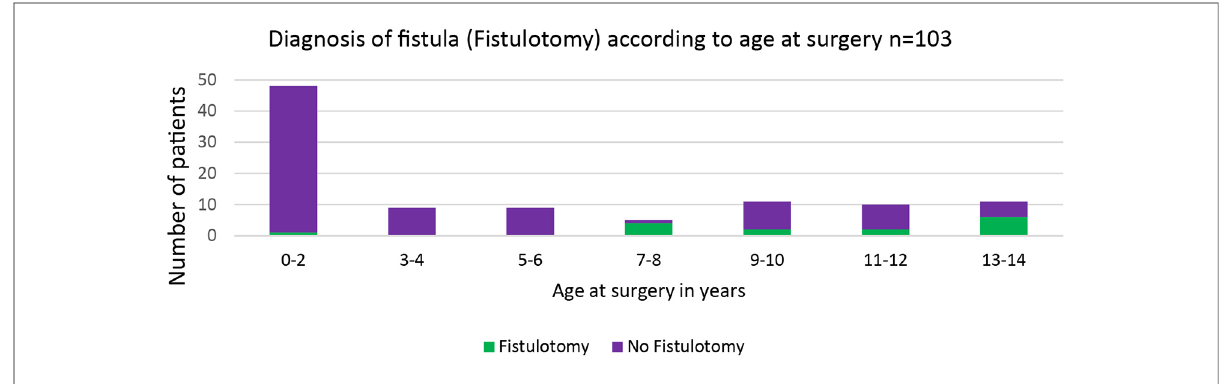
FIGURE 6 Diagnosis of fi stula as de fi ned by fi stulotomy at time of surgery relative to age.